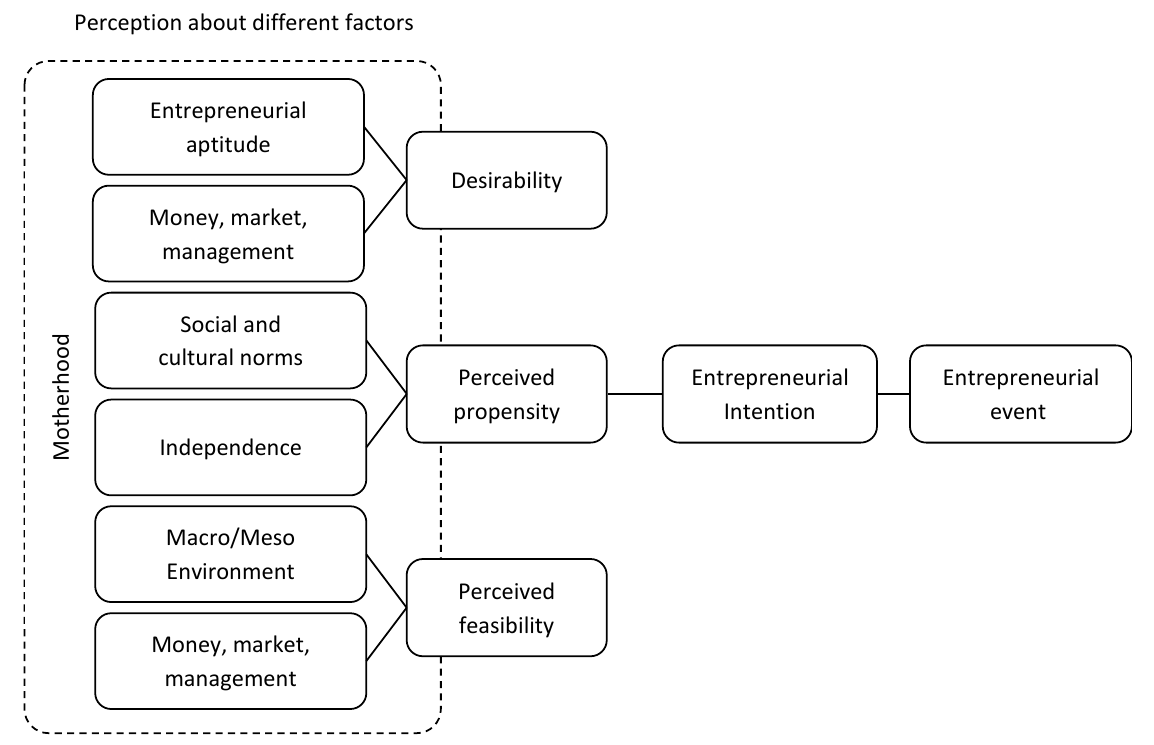
Figure 3. Theoretical Framework Developed from